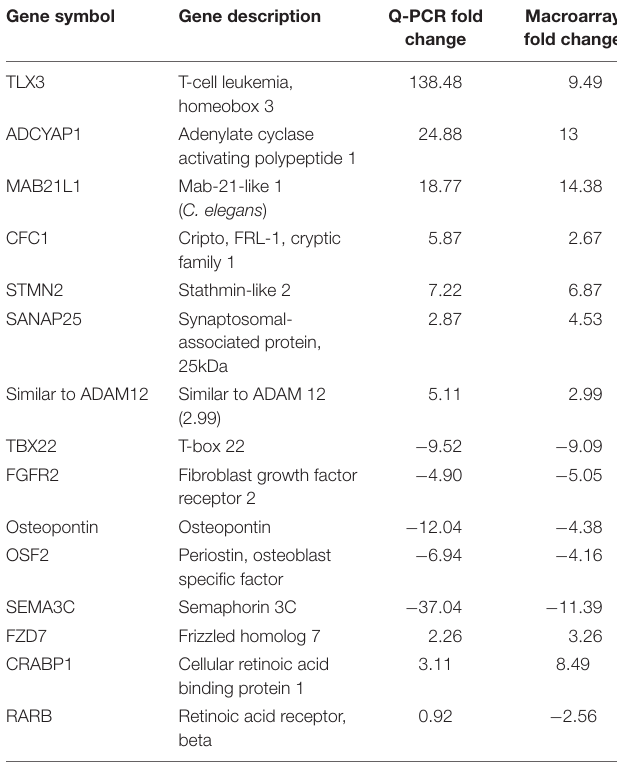
TABLE 2 | Quantitative PCR verification of the HH19 up-and down-regulated genes compared with HH16 tNCC. Gene